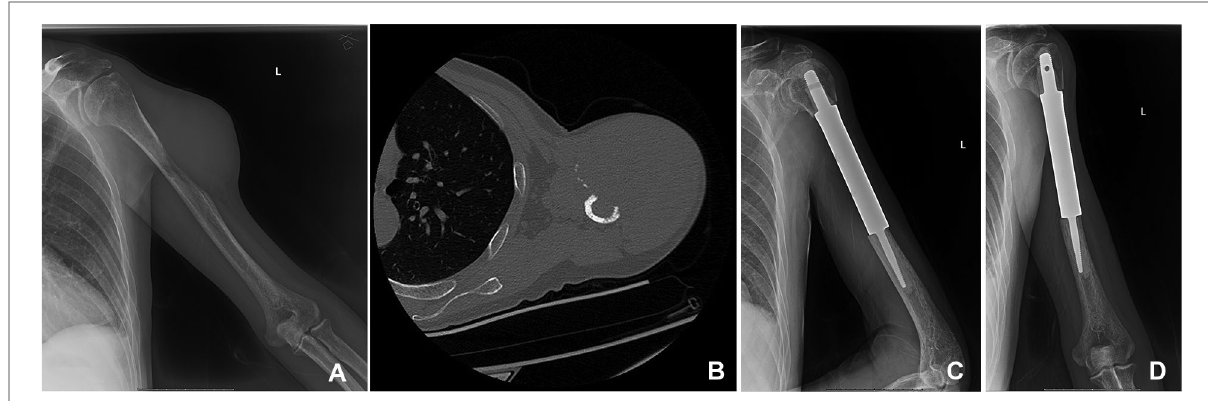
FIGURE 2 A 50-year-old man suffered from HCC with metastasis of the left humerus. The primary lesion of the liver was resected. ( A,B ) The bone metastasis in the middle part of the left humerus in x-ray and CT. ( C,D ) The patient underwent segmental tumor resection and arti fi cial tumor prosthesis